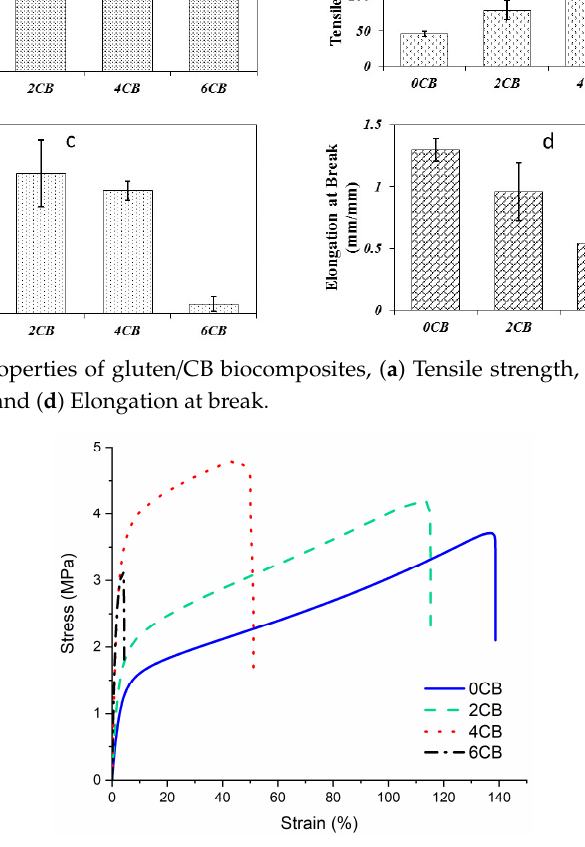
Figure 2. Stress vs. strain curves of gluten/CB biocomposites.